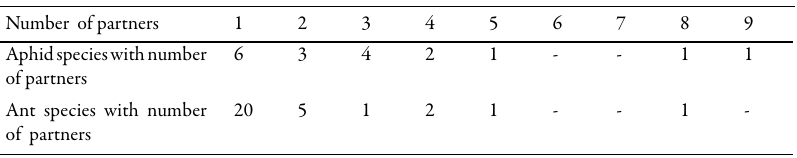
Table 1. Frequency distribution of the number of aphid or ant species with different partners in Costa Rica ( Greenidea not